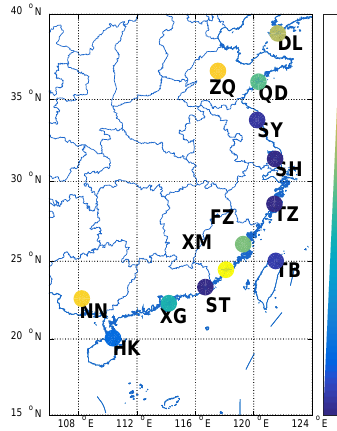
Fig 1. Distribution of 13 radiosonde stations in eastern China